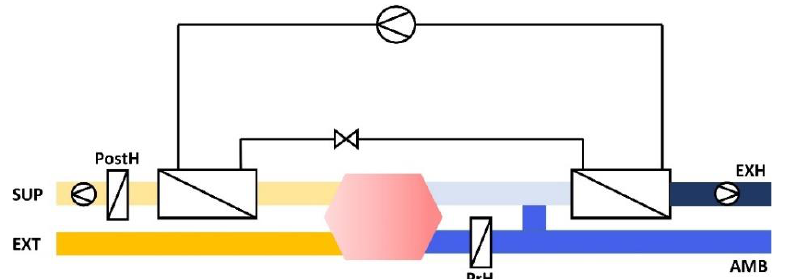
Figure 3. Scheme of exhaust-air to supply-air heat pump with MVHR and with post-heater (PostH) and pre-heater (PrH).